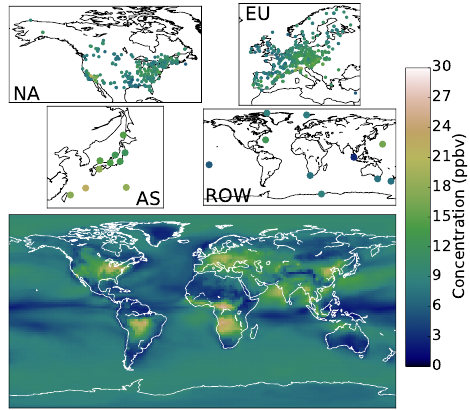
Figure 7. Seasonal phases of observations (upper panels) and model (lower panel). NA is North America, EU is Europe, AS is Asia, and ROW is rest of